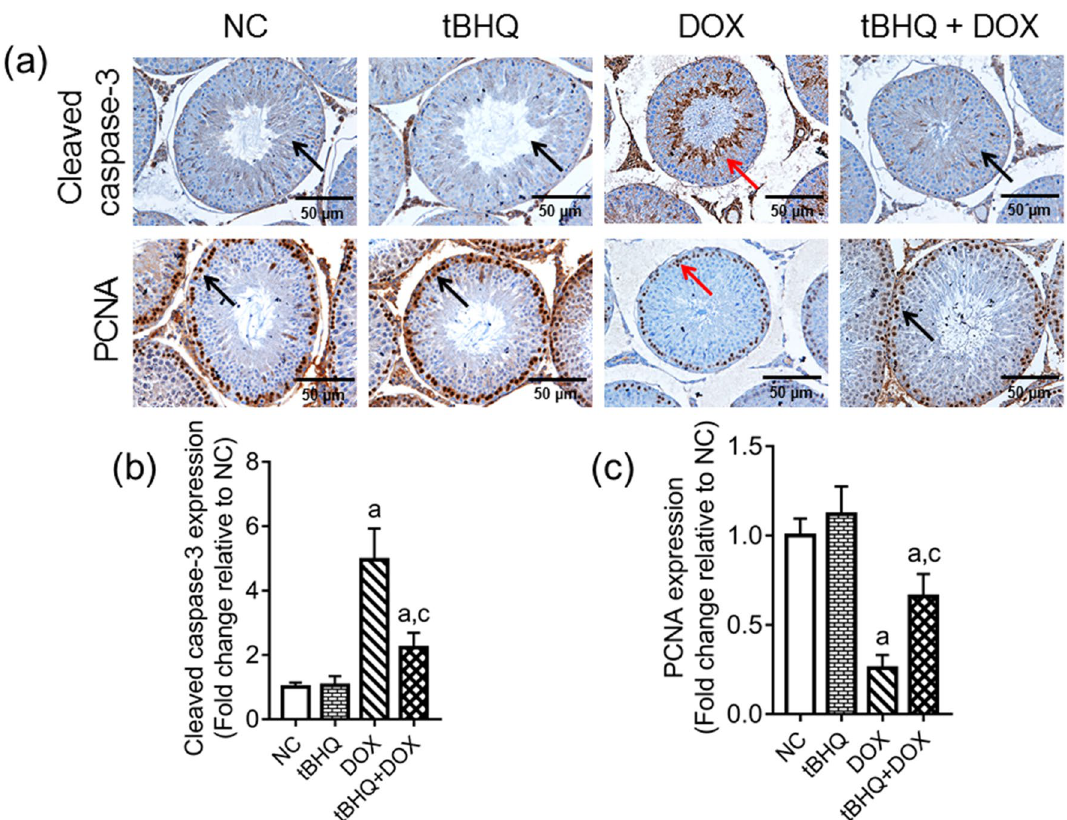
Figure 7. Effect of tBHQ on cleaved caspase-3 protein level ( a , b ) and PCNA protein level ( a , c ) in the testis of DOX-treated rats. NC: normal control, tBHQ: tert-butylhydroquinone, DOX: doxorubicin, PCNA: proliferating cell nuclear antigen. Cleaved caspase-3 protein level was highest in the seminiferous tubules of DOX group (red arrow) compared with the other three groups (black arrow), while PCNA protein level was lowest in the seminiferous tubules of DOX group (red arrow) relative to the other three groups (black arrow). Magnification: × 400, scale bar: 50 µm. For numerical data representing cleaved caspase-3 ( b ) and PCNA ( c ) protein levels, values are mean ± SD, n = 6/group. a p < 0.05 versus NC; c p < 0.05 versus DOX (One-way ANOVA with Tukey’s post-hoc